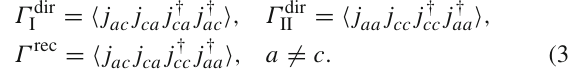
One also obtains a decay width of the order of N − 2 [Eq.